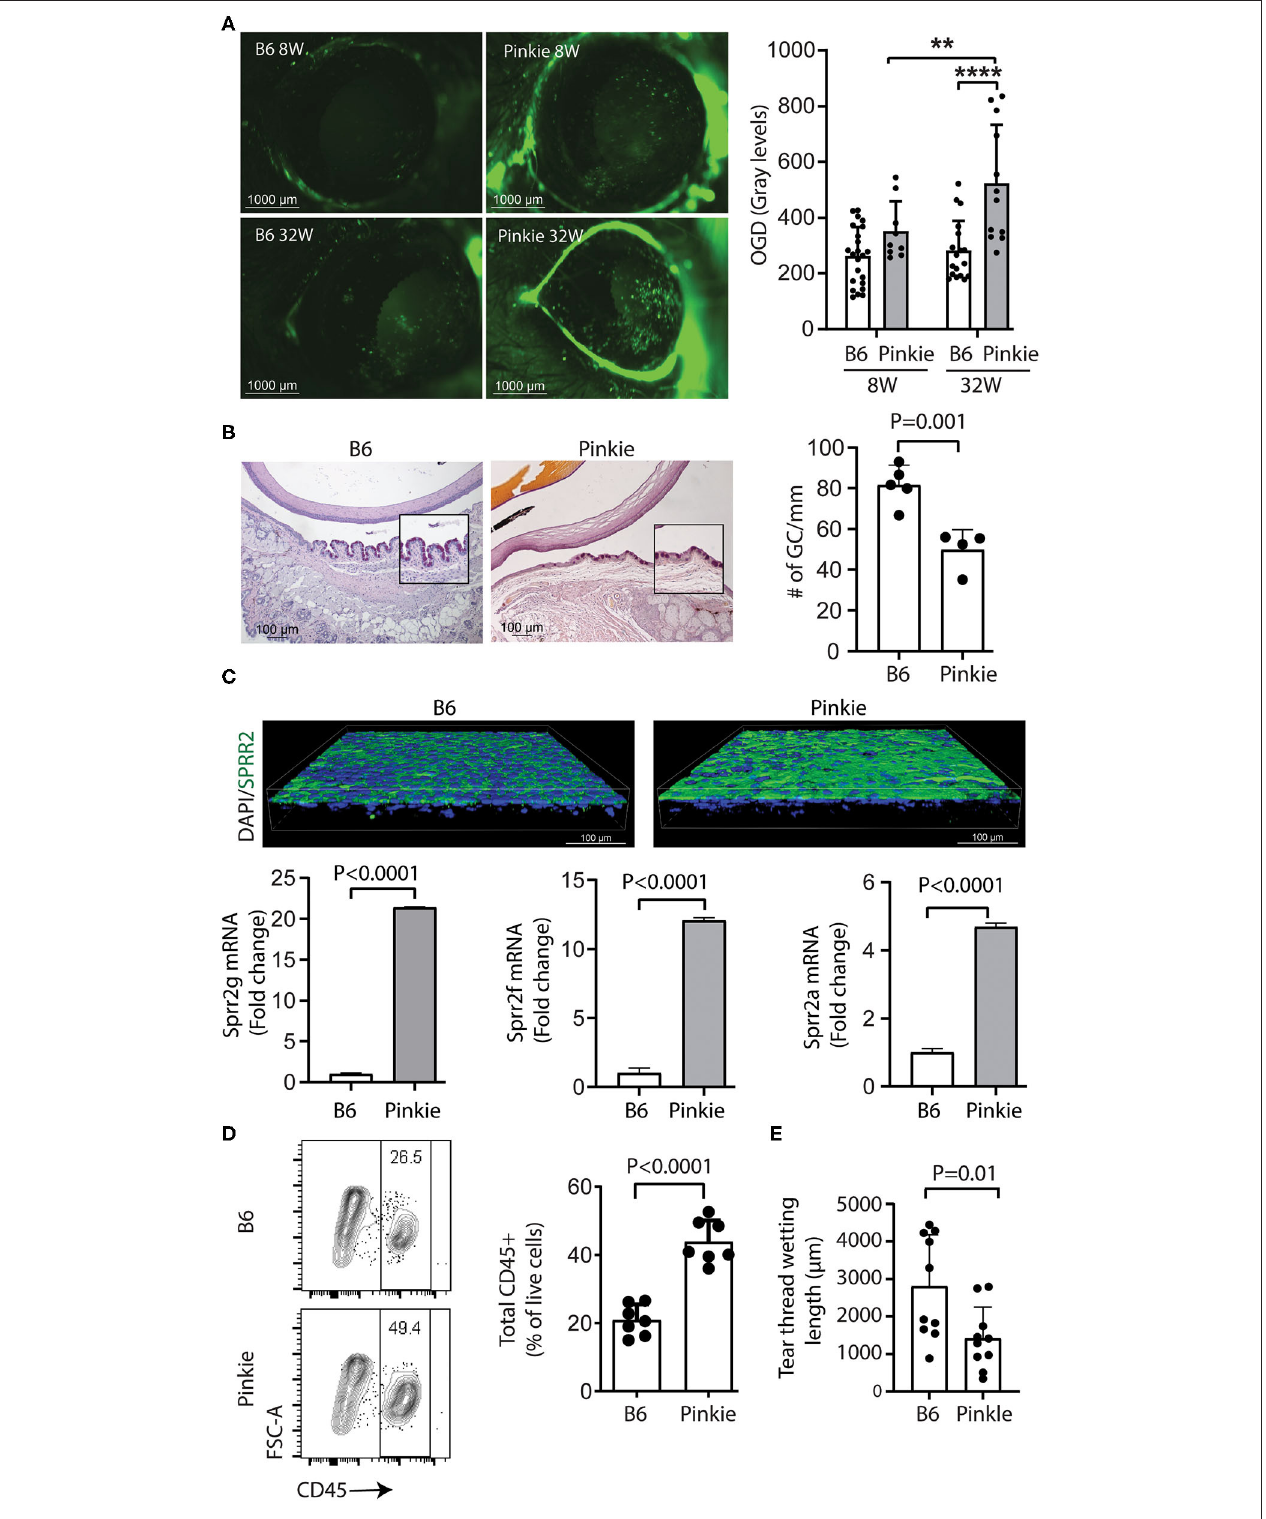
FIGURE 1 | The Pinkie strain with reduced Rxr α signaling develops dry eye disease. (A) Dry eye phenotype in Pinkie strain. Representative Oregon Green dextran (OGD) staining of corneas from 8- to 32-week-old C57BL/6 (B6) and Pinkie strains (left) and graph showing mean gray level fluorescence ( n = 9–22/group). Mean